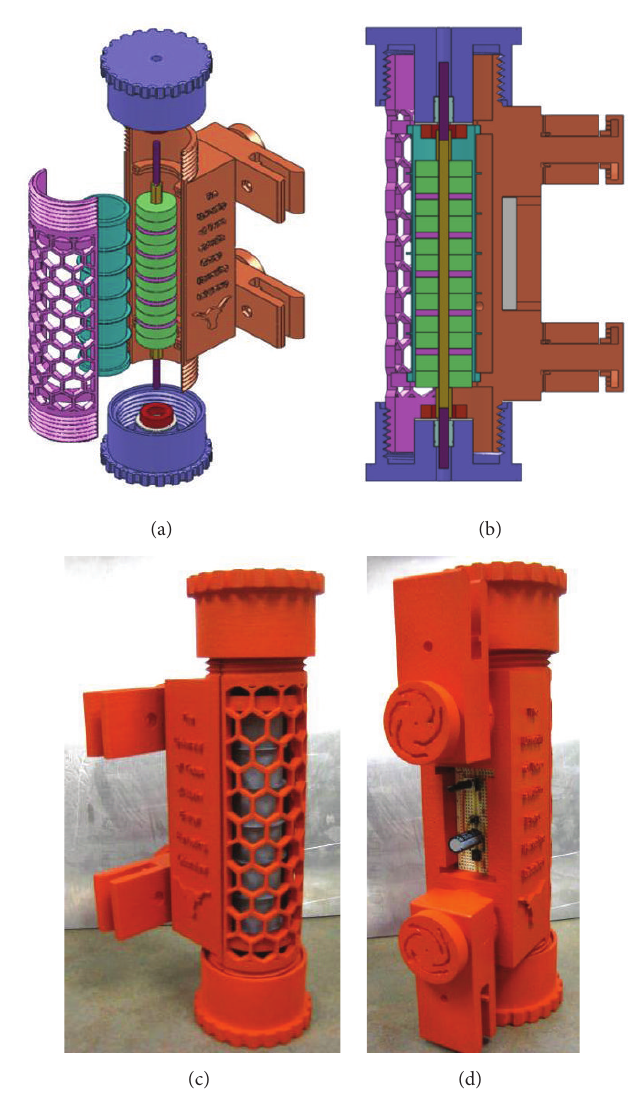
Figure 8: EM-VEH developed by [15]: (a) exploded view of EM-VEH prototype, (b) cross-section view of EM-VEH, (c) 3D printed EM-VEH, and (d) assembled EM-VEH with vibrating magnet